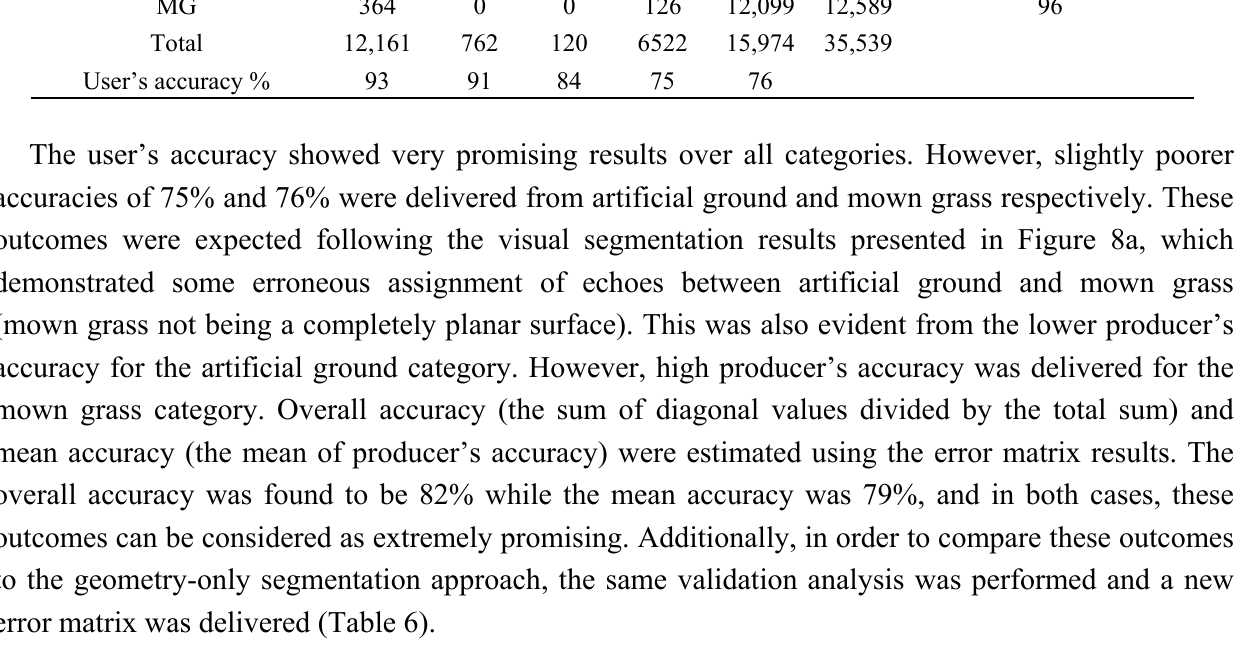
Table 6. Error matrix detailing FWF echo counts based only on geometric